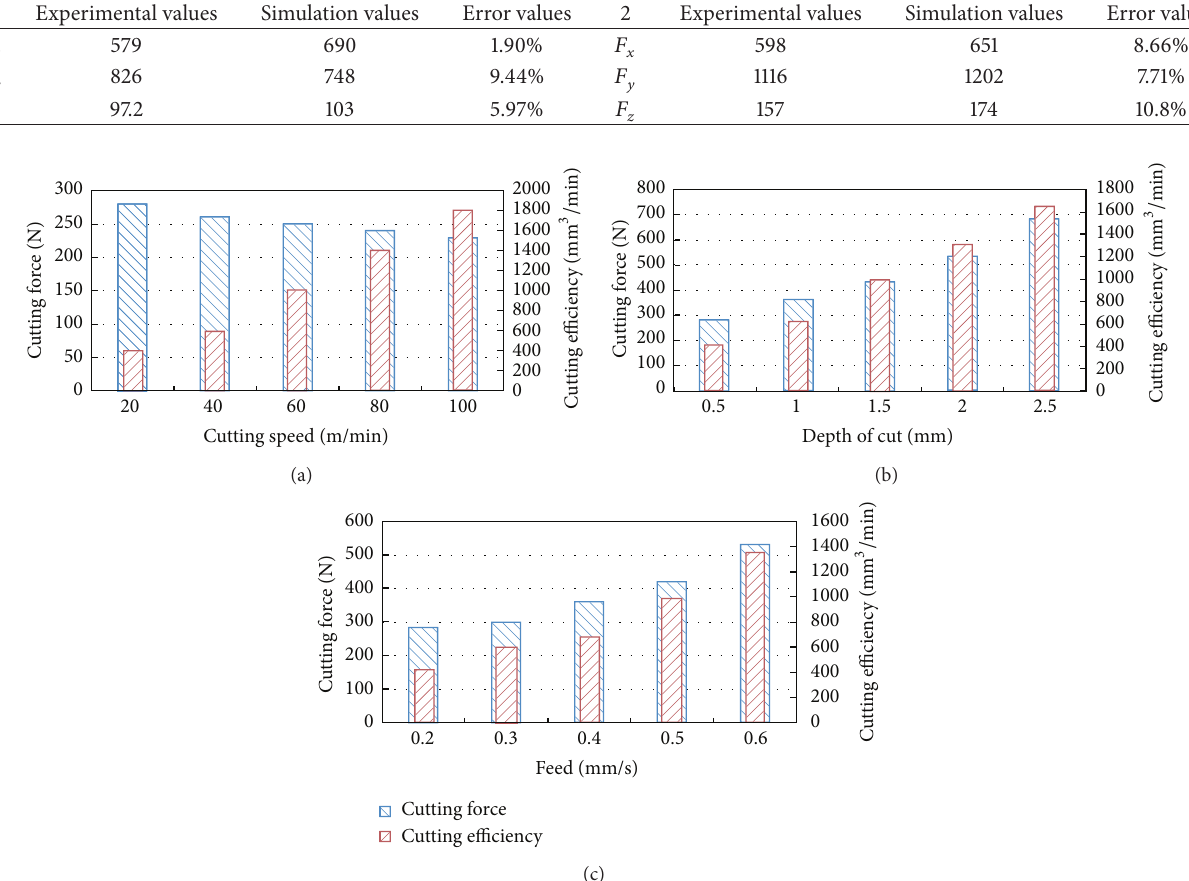
Figure 8: (a) Cutting force and cutting efficiency contrast in different cutting speed (cutting depth 0.5 mm; feed 0.2 mm/s). (b) Cutting force and cutting efficiency contrast in different depth of cut (cutting speed 20 mm/min; feed 0.2 mm/s). (c) Cutting force and cutting efficiency contrast in different feed (cutting speed 20 mm/min; cutting depth 0.5